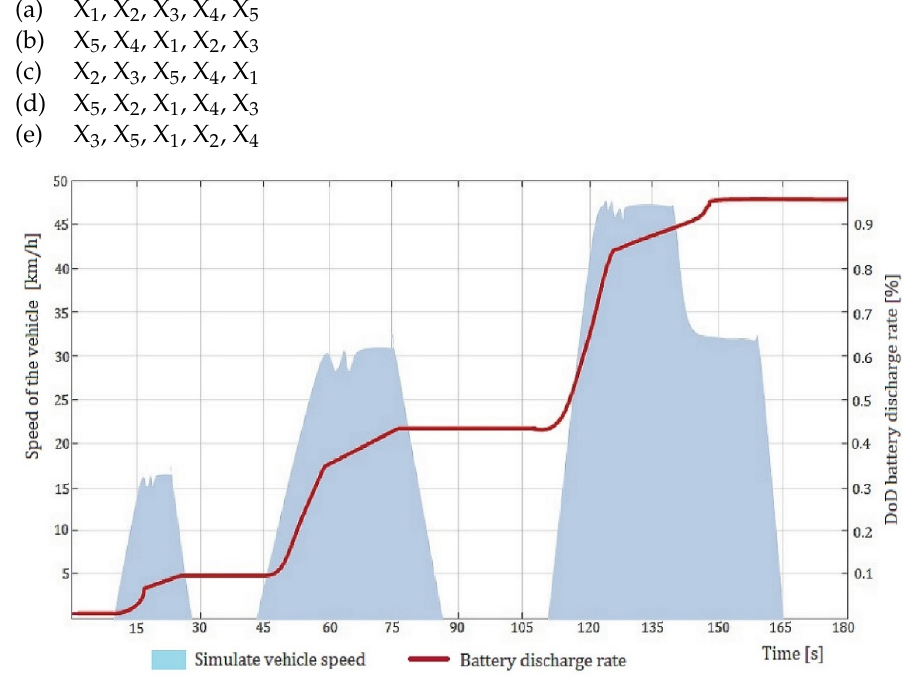
Figure 12. Plot of the battery discharge rate and speed of an electric car for a multi ‐ valued logic tree with the floor layout of decision variables of: X 1 , X 2 , X 3 , X 4 , X 5 .